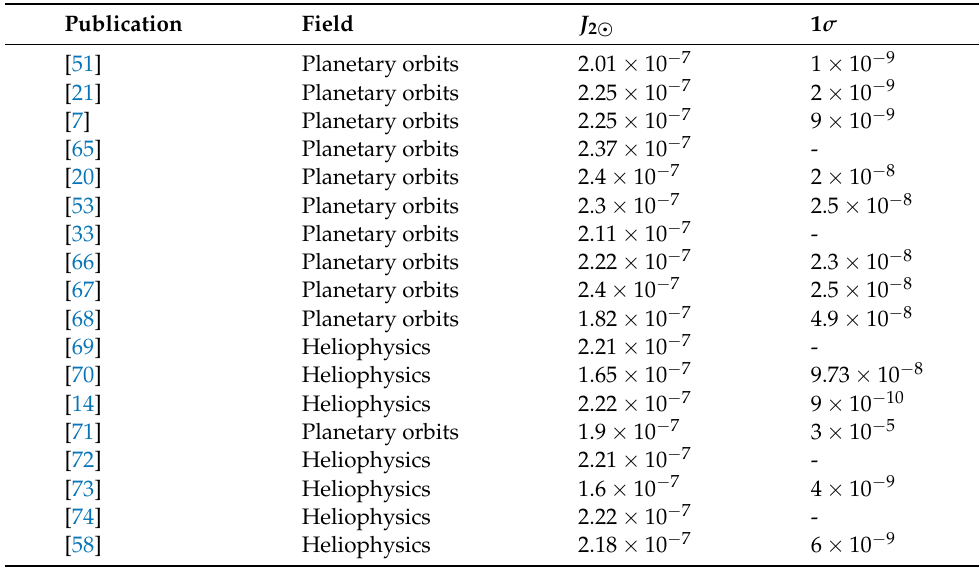
Table A1. Selected attempts to determine J 2 (cid:12) over the last 25 years, as shown graphically in Figure 1. For comprehensive lists of attempts, see